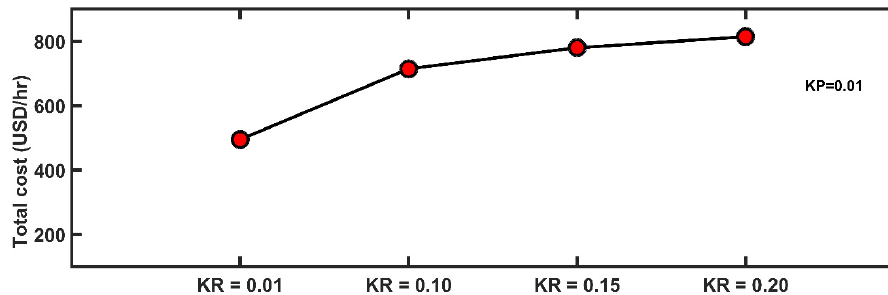
Figure 13. Total generation cost versus K R .